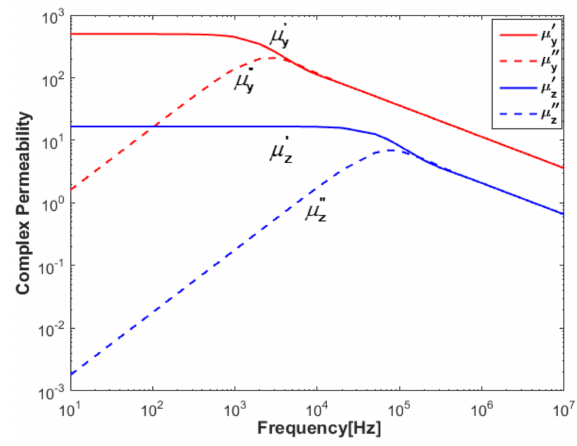
Figure 4. Relative complex permeability of the transformer